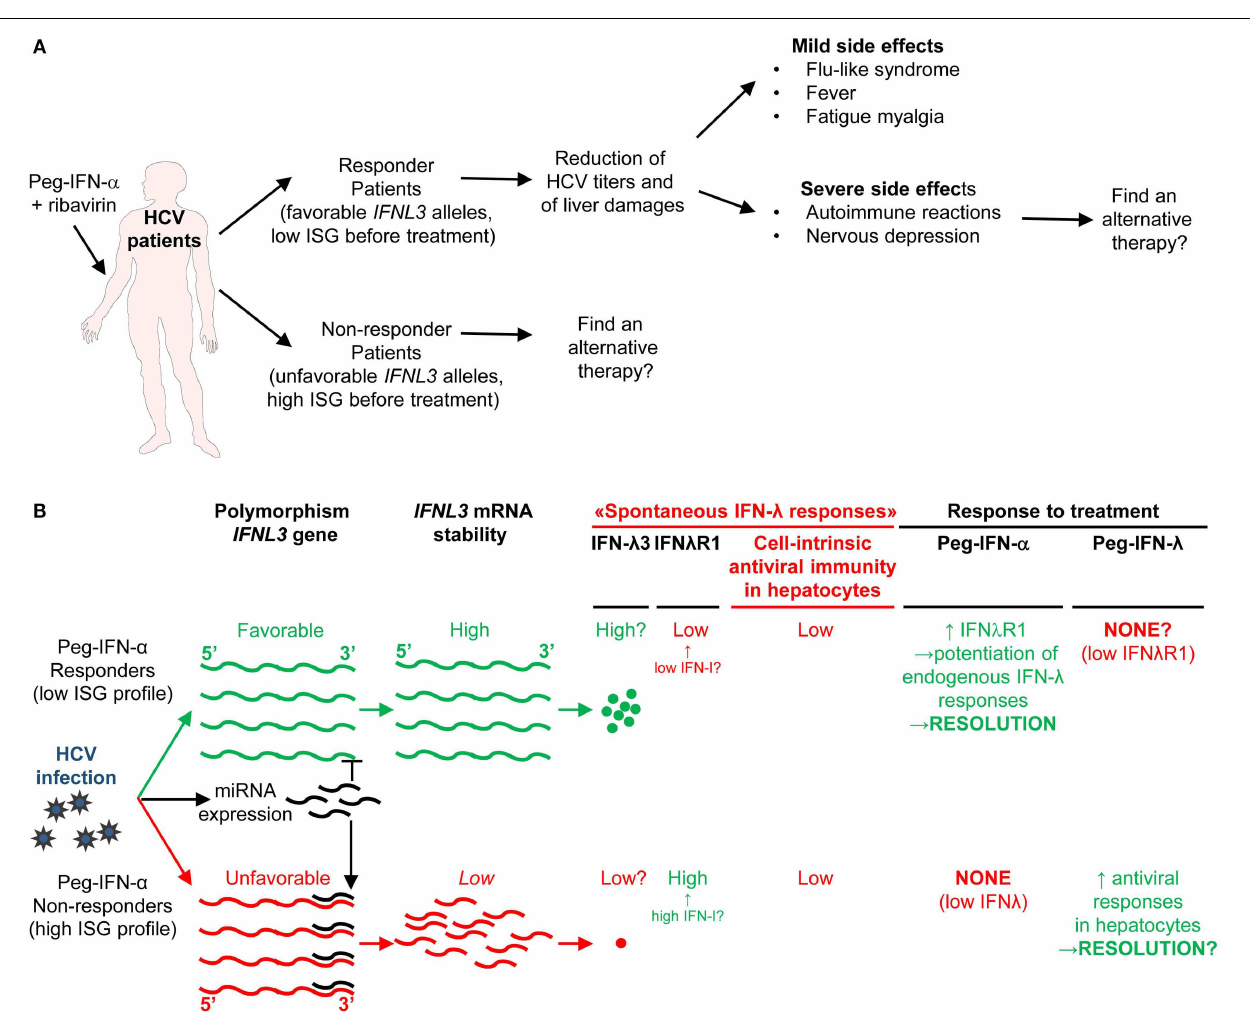
UTR of IFNL3 mRNA to promote their degradation.The favorable IFNL3 allele associated with responsiveness to PEG-IFN- α treatment may allow endogenous expression of sufficient levels of IFNL3 for efficient induction of cell-intrinsic anti-viral defenses in hepatocytes.This process is, however, hampered by the limited expression of the receptor for this cytokine (IFN λ R1) in these patients. PEG-IFN- α treatment might promote resolution of the infection by inducing IFN λ R1 in these patients, potentiating their response to their endogenous production of IFNL3. In the patients that do not respond to PEG-IFN- α treatment, endogenous levels of IFNL3 are insufficient for efficient induction of cell-intrinsic anti-viral defenses in hepatocytes, due to the degradation of the corresponding mRNA in infected hepatocytes. In these patient’s hepatocytes, however, IFN λ R1 is already expressed to high levels prior to treatment due to their high endogenous IFN-I responses. Administration of exogenous IFN- λ might cure these patients. See main text for further